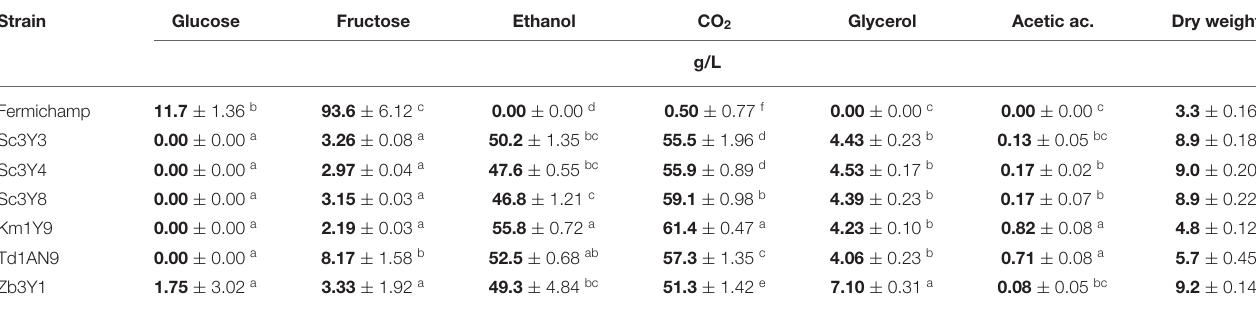
TABLE 3 | Residual hexoses and primary metabolite production for the selected yeast strains at 96h fermenting as individual inoculum on Agave medium. Strain